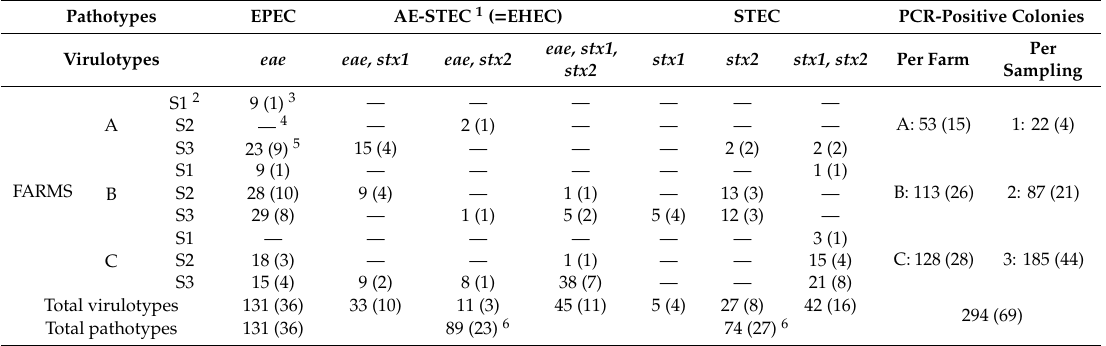
Table 2. Pathotypes and virulotypes of the triplex PCR-positive colonies according to the farms and sampling